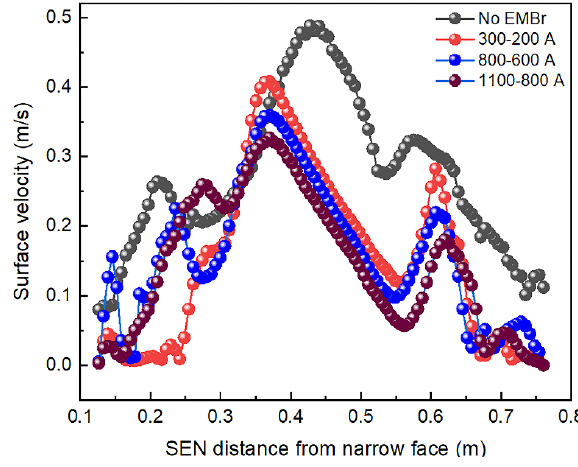
Figure 14. Funnel mold surface velocity.